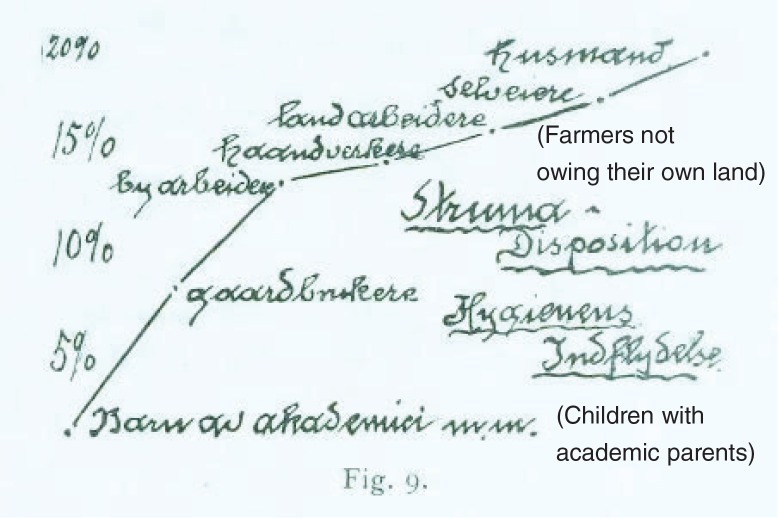
Social factors that influenced the goiter frequency in Norway. This is a handwritten note by Carl Schiøtz, who investigated the prevalence of goiter in the Norwegian inland county Hedmark in 1914. In the figure, he indicates the prevalence according to social class: the lowest prevalence was among children of academics, the highest prevalence among farmers not owning their own land (a cotter) (English translation in brackets).